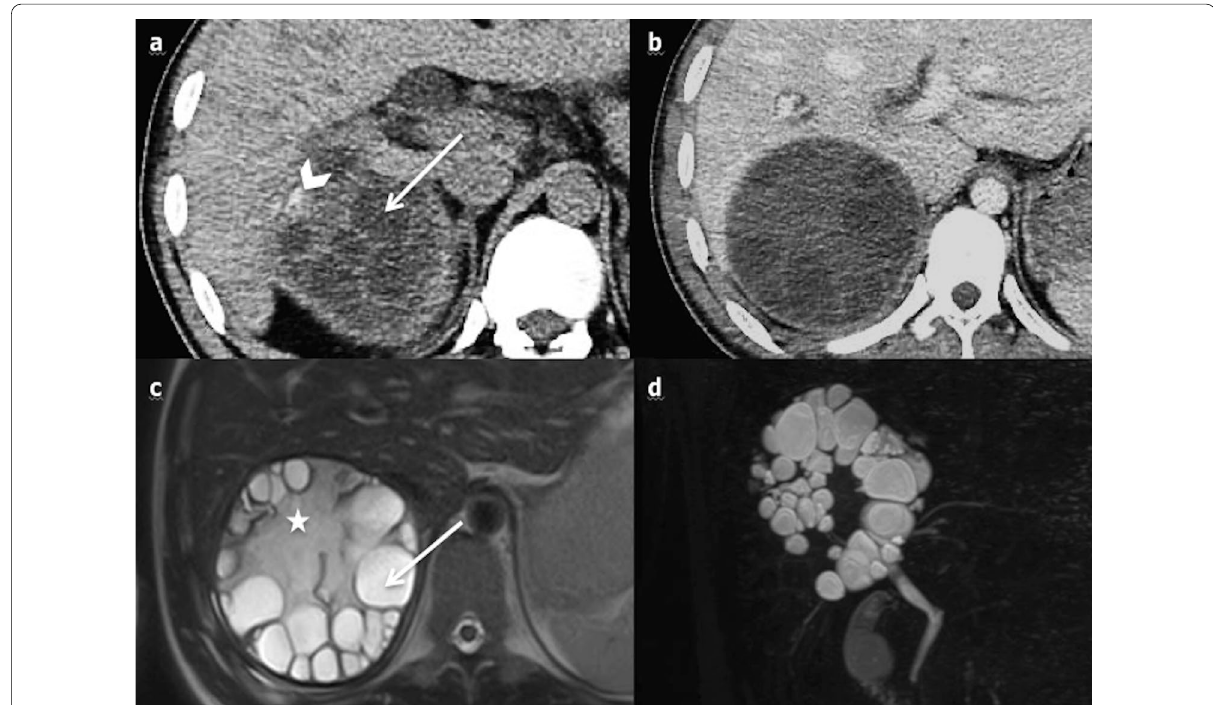
Fig. 29 cyst echinococcosis 2, in a 50-year-old male. a Axial non-enhanced computed tomography shows a heterogeneous mass with a cystic part (arrow) and calcification of the wall (arrowhead). b On axial computed tomography on portal venous phase no enhancement of the cystic component is observed. c The cystic part and the differentiation between the daughter (arrow) and the mother (star) cysts are better evaluated on axial T2-weighted magnetic resonance imaging. d Coronal 3D magnetic resonance cholangiopancreatography excludes biliary fistula from the possible